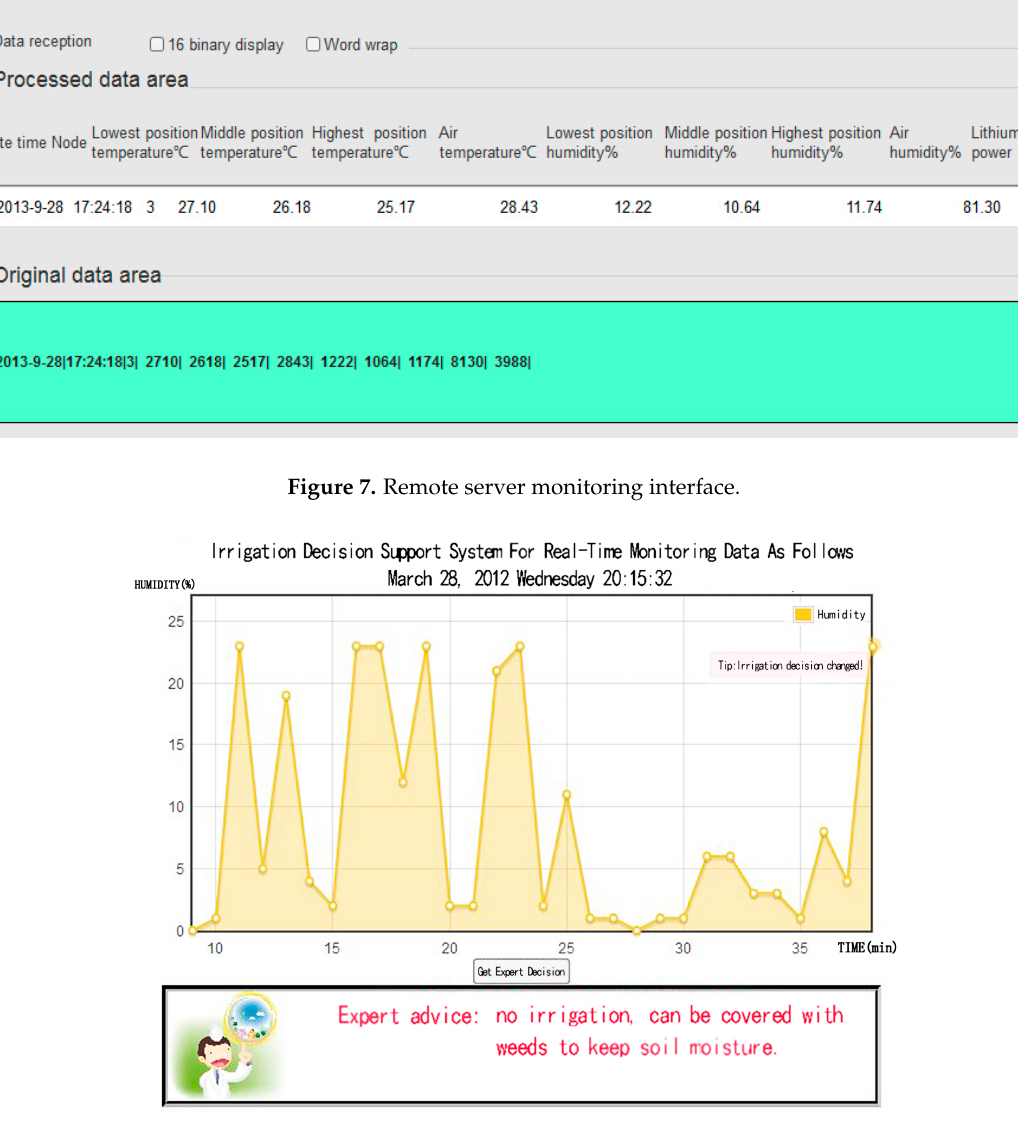
Figure 8. Irrigation decision support interface.